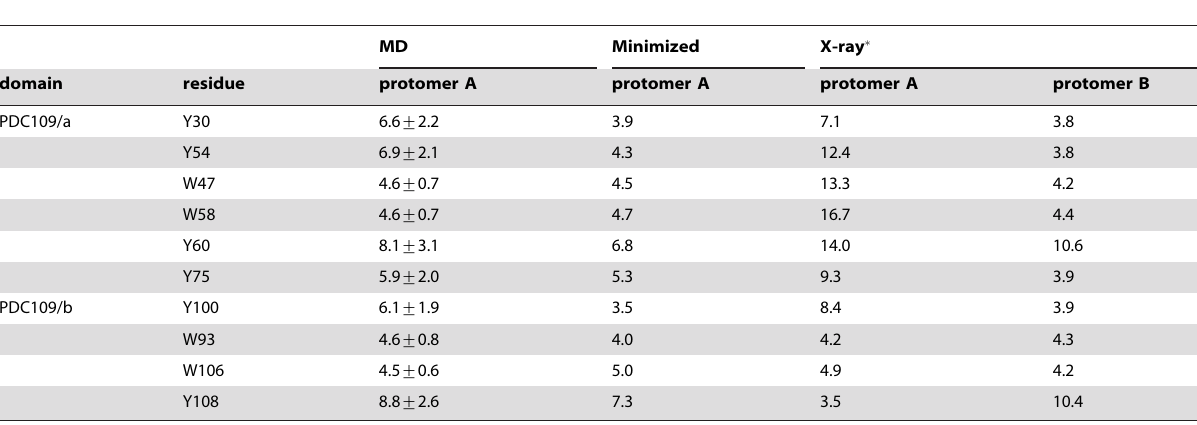
Table 1. MD and X-ray results for distances between binding sites of PDC109 and